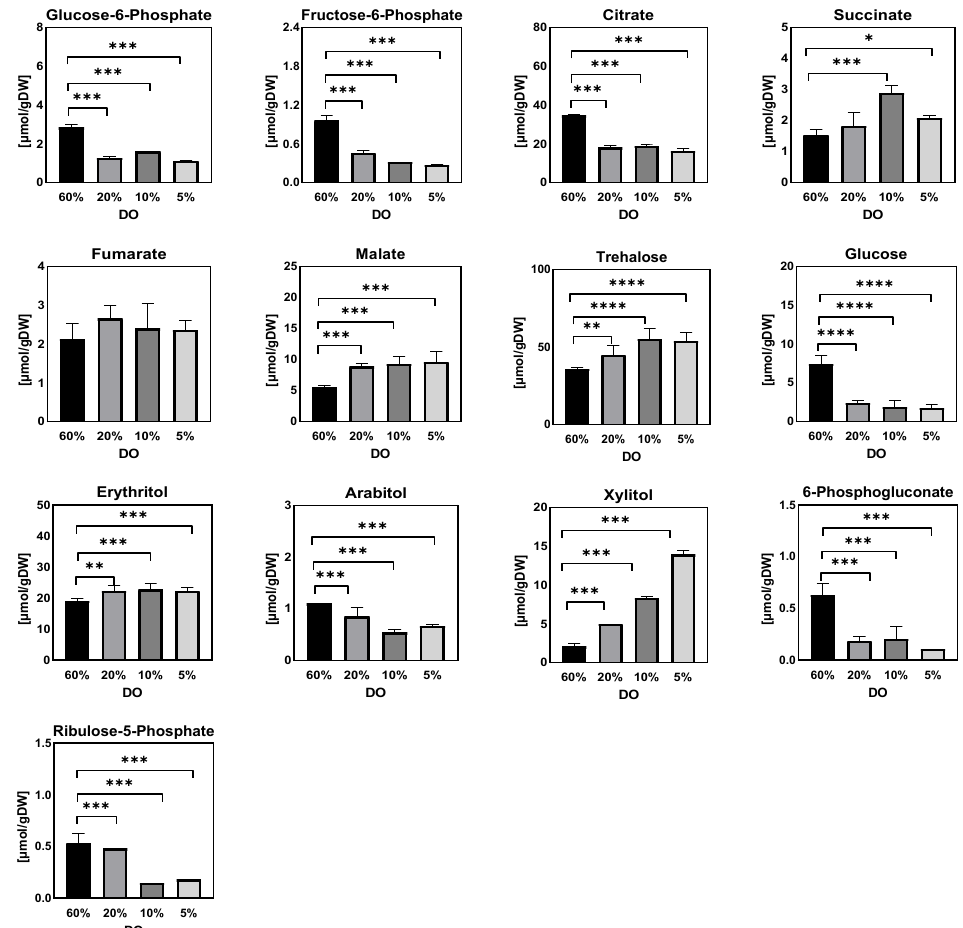
Figure 5. Intracellular amounts of sugar phosphates, organic acids, and sugar alcohols in Penicillium chrysogenum Wisconsin 54-1255 under steady-state dissolved oxygen (60%, 20%, 10%, and 5%). Samples were collected at 24 h intervals and data were collected from three replicate experiments; Two-tailed Student’s t -tests ((*) p < 0.05, (**) p < 0.01, (***) p < 0.001 and (****) p < 0.0001) were performed using GraphPad Prism